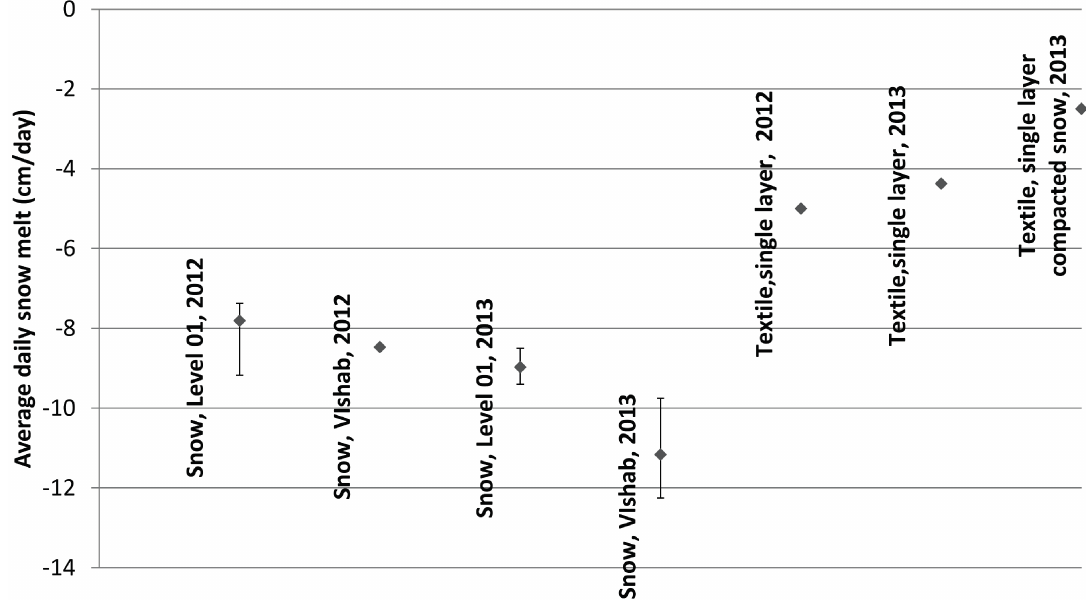
Figure 6. Average daily snow ablation rates in cm between 17 June and 24 July 2012 and between 22 June and 27 June 2013 . If more than one measurement site was available, the range is indicated by